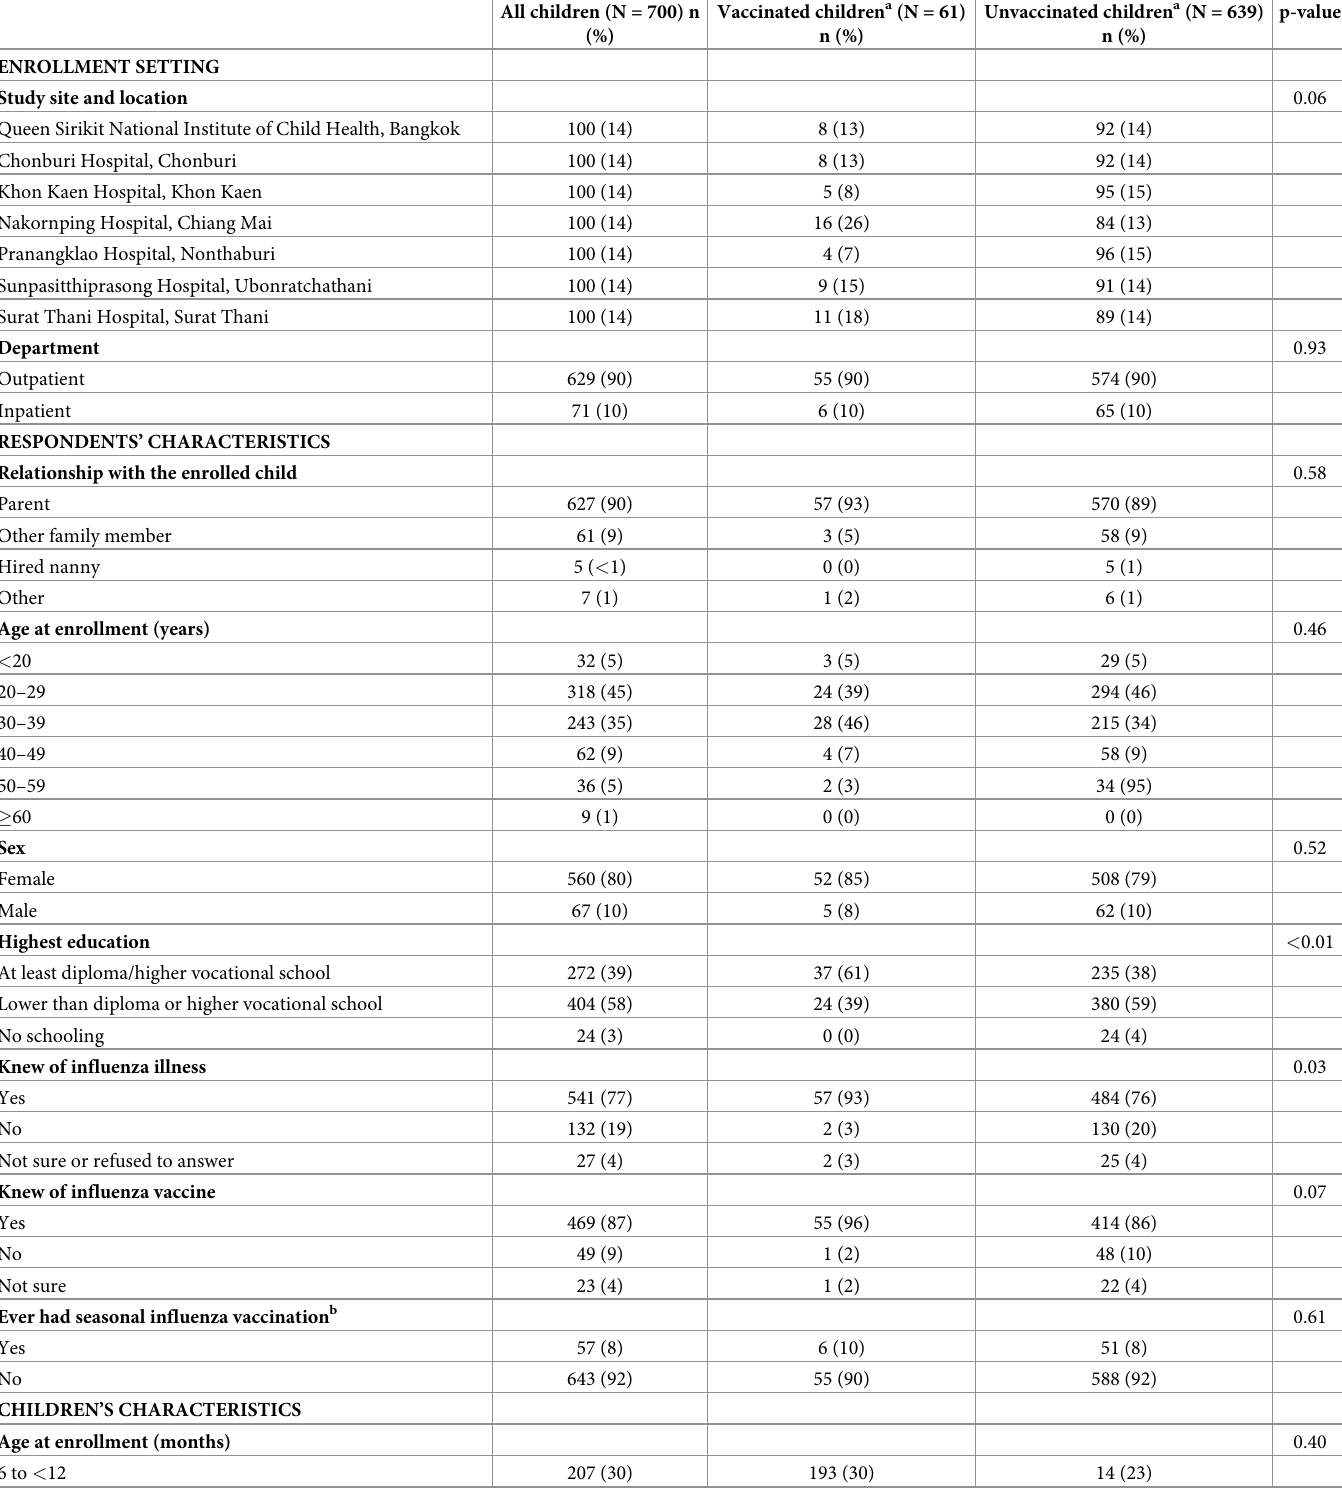
Table 1. Characteristics of respondents and children who completed the knowledge, attitude/perception, and practice survey, Bangkok, Thailand